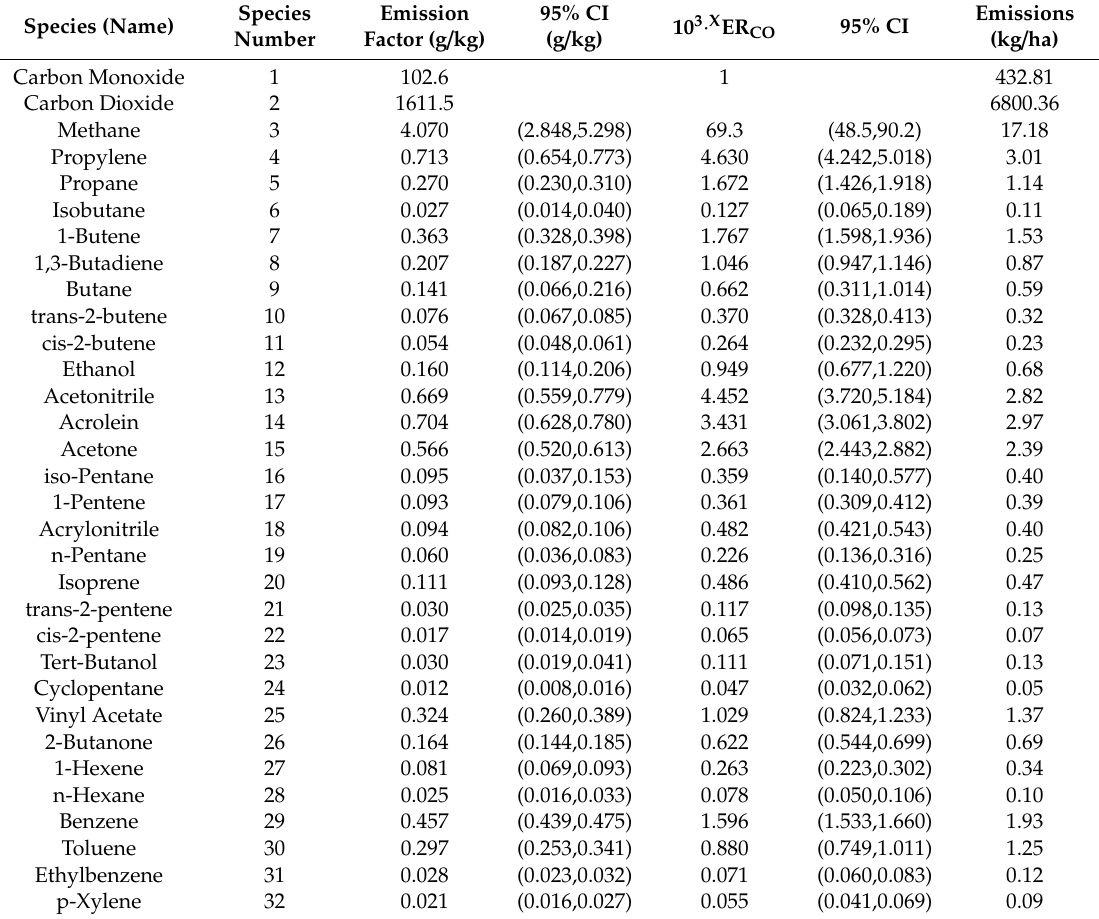
Table 1. Estimated emission factors (in grams of species per kilogram of dry